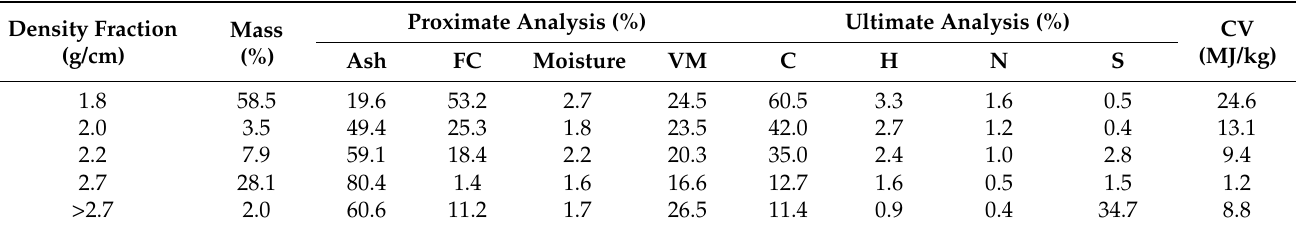
Table 5. Sink and float results in terms of mass recovery, calorific value, and ultimate and proximate analysis. Where: FC = fixed carbon; VM = volatile matter; C = carbon; H = hydrogen; N = nitrogen; S = sulfur; and CV = calorific value.